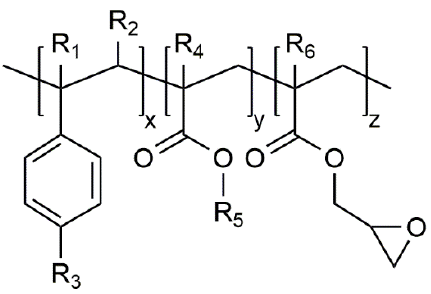
Figure 1. General structure of the styrene–acrylic multi-functional chain extenders according [7] .